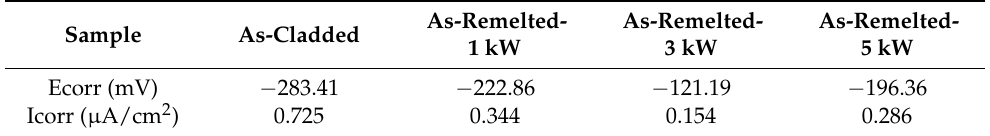
Table 4. Polarization curve test results.